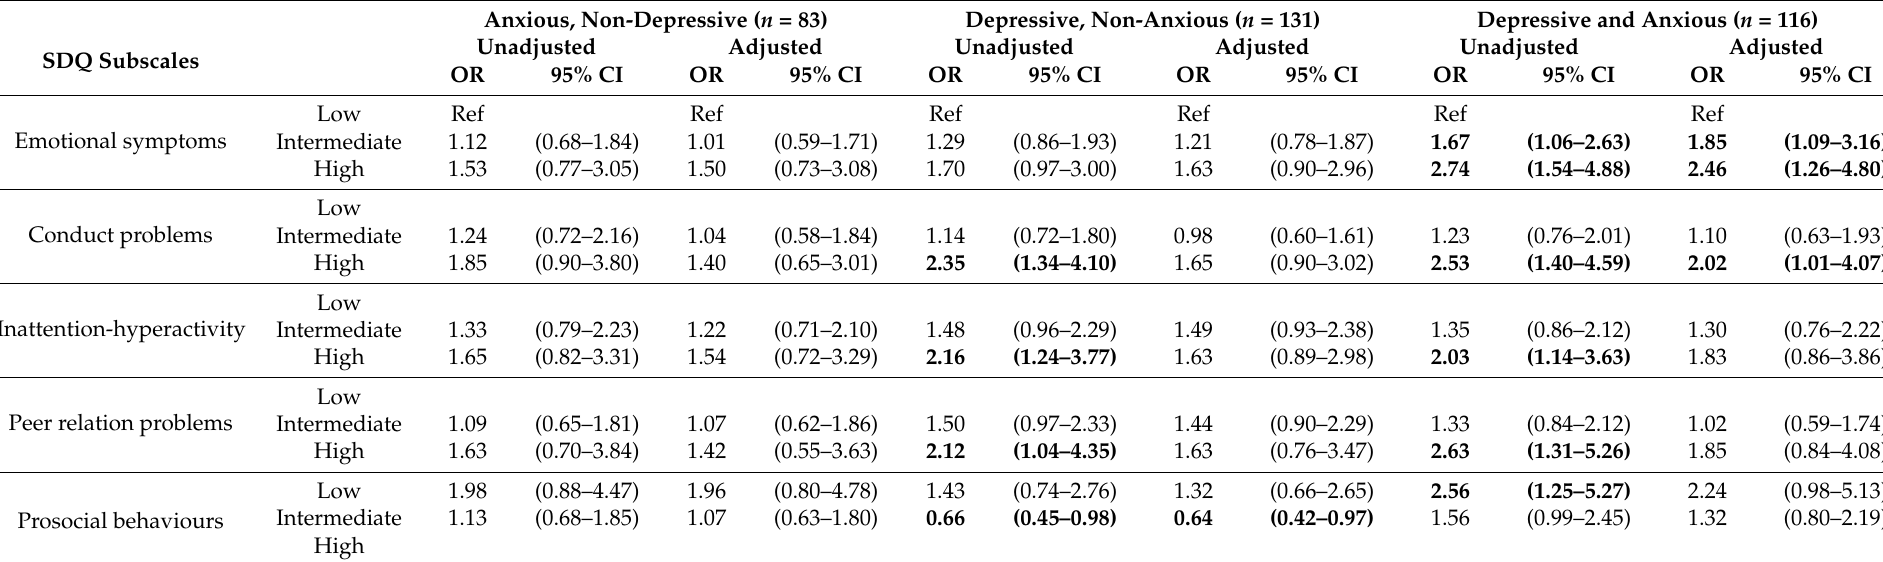
Table 2. Unadjusted and IPW-adjusted multinomial regressions comparing associations with child’s trajectories in each group with any mental health problem symptoms (depressive only, anxious only, comorbid depressive and anxious) to associations in the reference group (no symptoms ( n = 805)). Anxious, Non-Depressive ( n = 83) Depressive, Non-Anxious ( n =